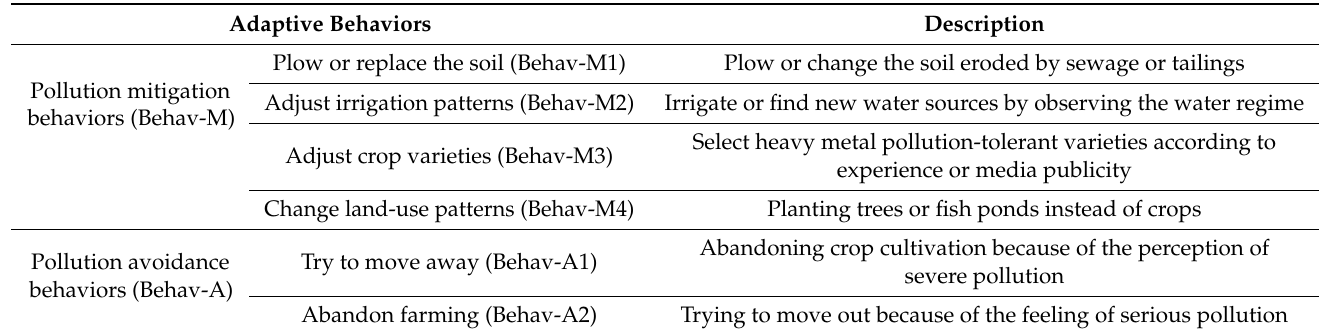
Table 1. Farmers’ adaptive behaviors toward heavy metal-polluted cultivated land.